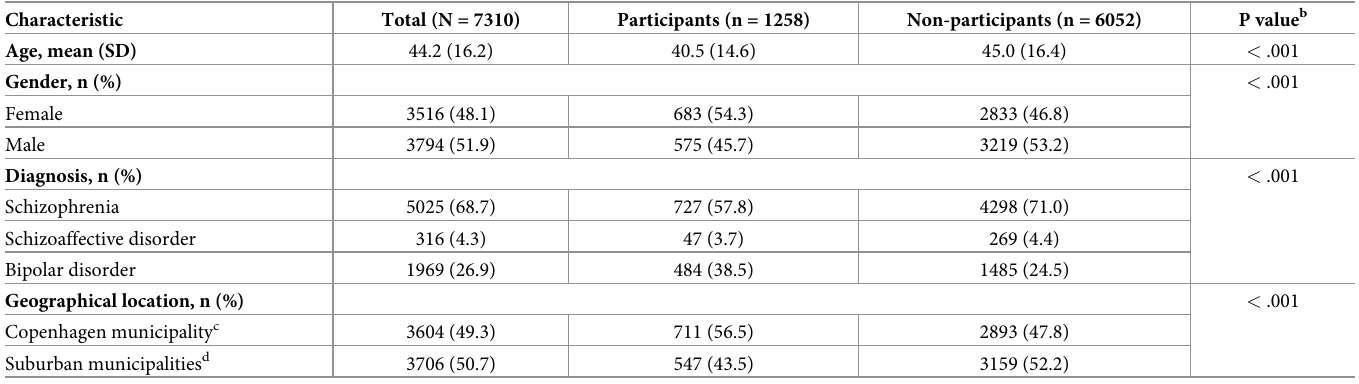
Fifty-nine of 1258 included patients had a positive SARS-CoV-2 antibody test, corresponding to a adjusted seroprevalence of 4.96 (95% CI 3.87–6.35). No significant difference was found Table 2. Baseline characteristics of total study population by study participation a